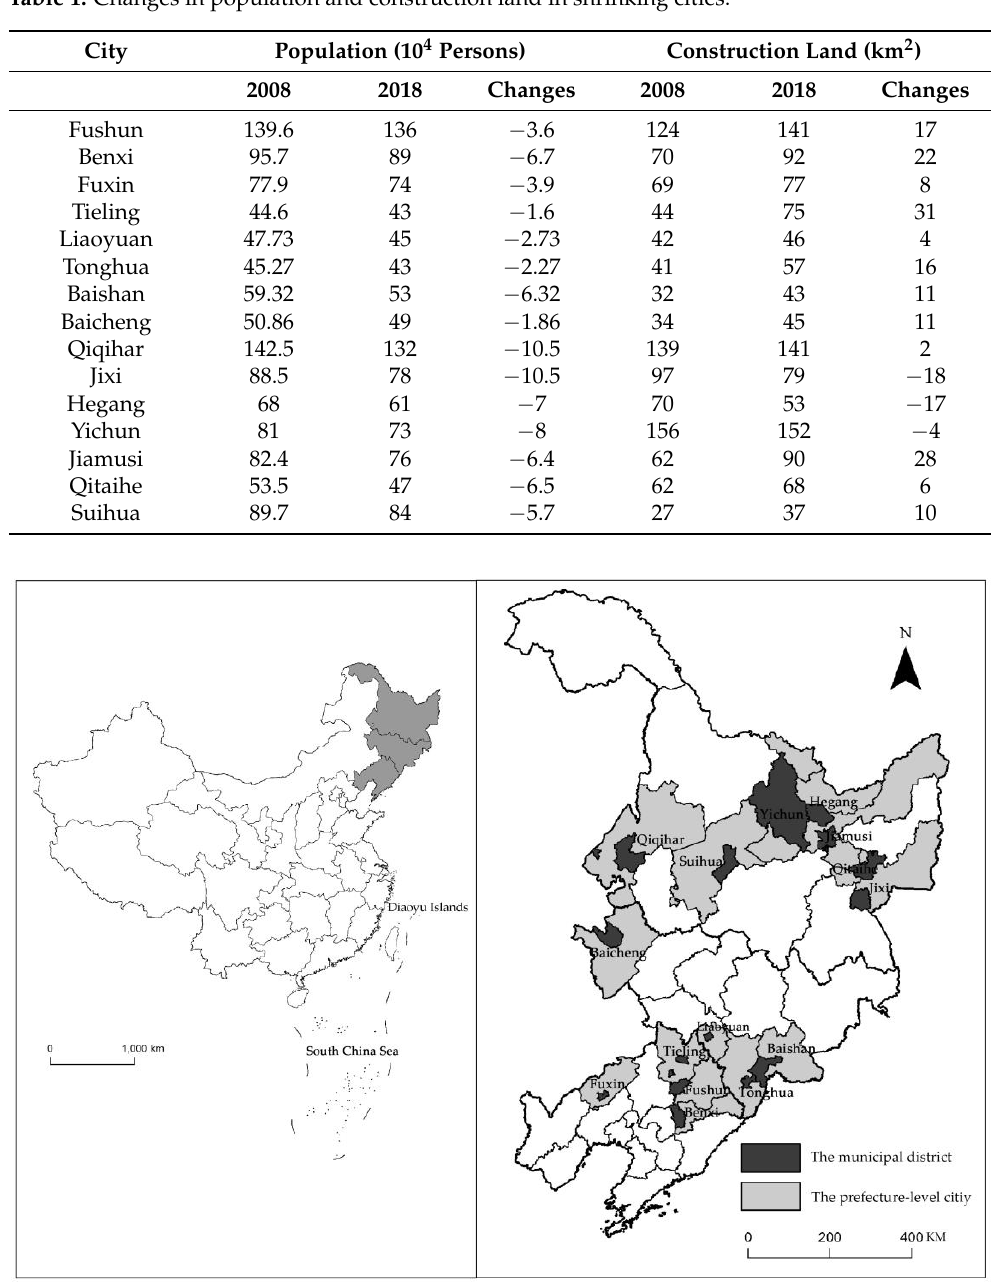
Figure 2. The distribution of shrinking cities in Northeast China. (Source: Authors). Table 1. Changes in population and construction land in shrinking cities.